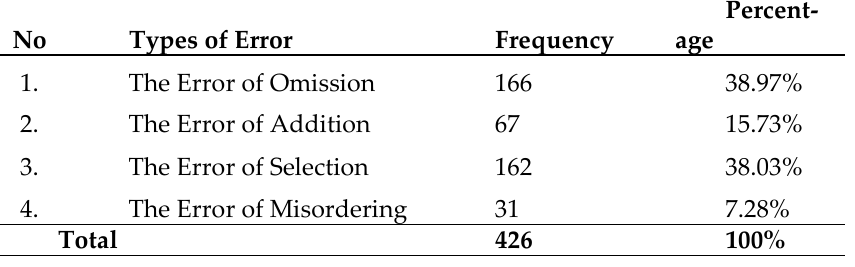
Table 4.2. The Recapitulation of Error Types, Frequency and its